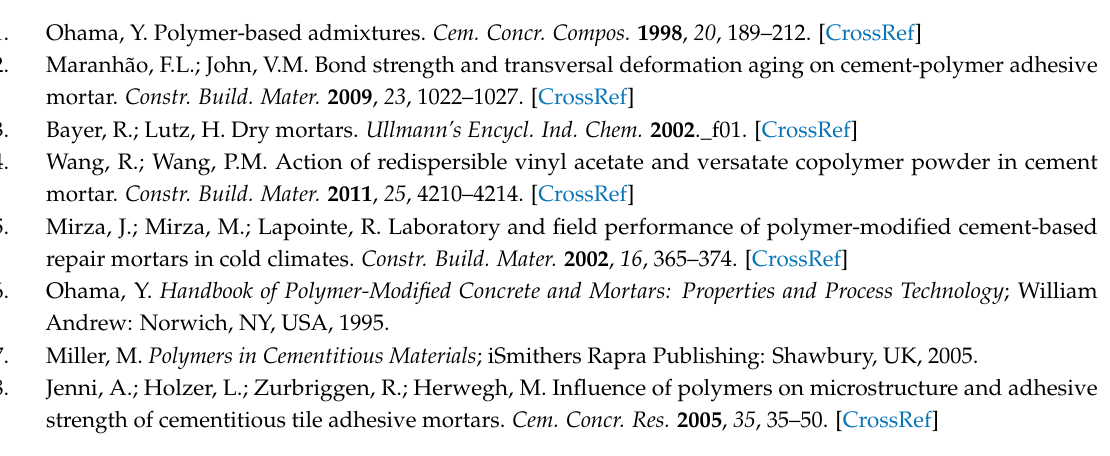
s1, Figure S1: Number of polymer particles in the reactor during the synthesis of sample a , Figure S2: Sketch of the membrane preparation procedure for crack-bridging tests, Figure S3: Cement-based membrane obtained with polymer h and i , after spray drying, Figure S4: NMR spectra for the monomers STY and 2-EHA and for the copolymer STY/2-EHA a , Table S1: Reaction formulations for different core-shell particles for samples a–e , Table S2:, Reaction formulations for different core-shell particles for samples f–j , Table S3: Surface zeta potential, pH value and film-forming abilities of synthesized latexes, Table S4: 2-EHA content of the cumulative polymer particles during the